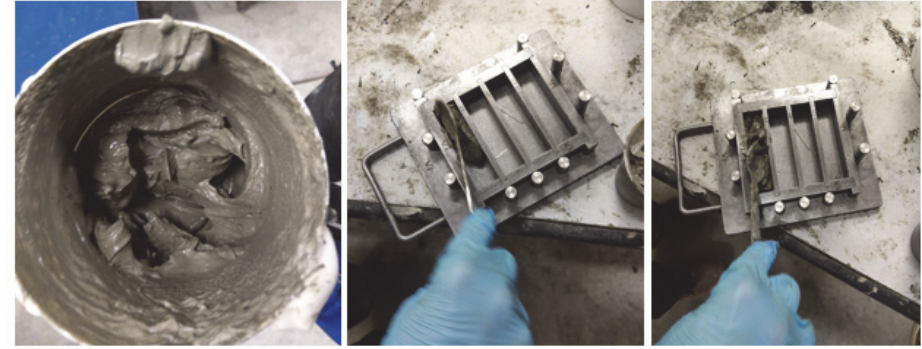
Figure 1: Foamed concrete paste at the fresh state (left) and pouring into formworks for the realization of prismatic beams.